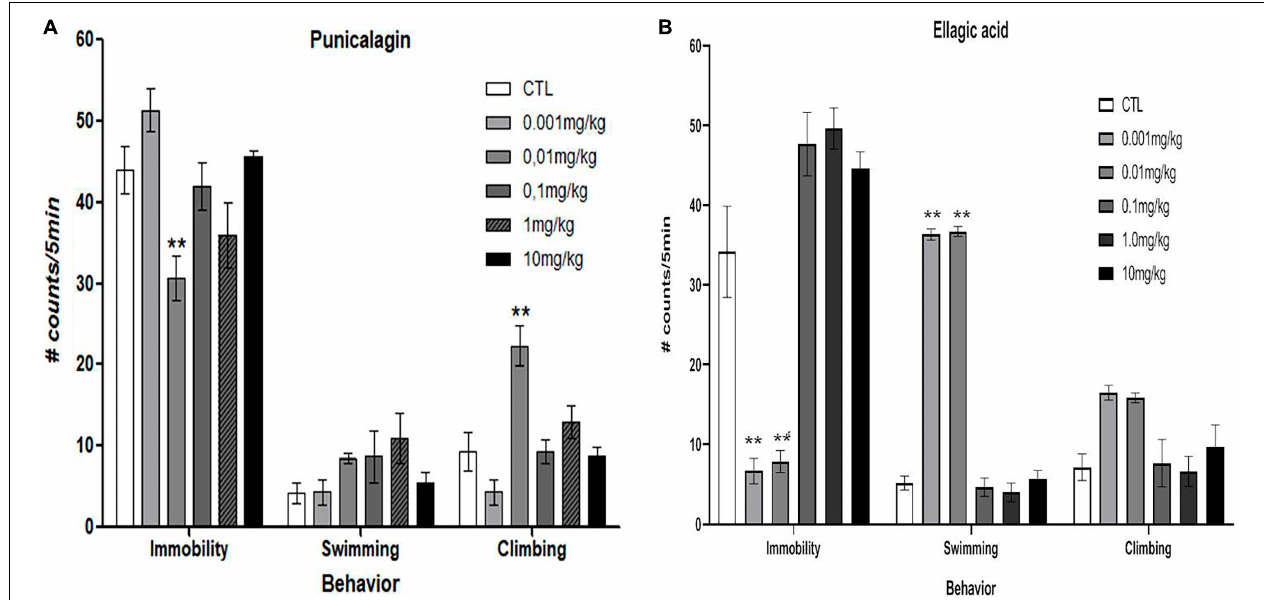
FIGURE 3 | Effect of chronic administration (0.001, 0.01, 0.1, 1.0, and 10 mg/kg, i.p, once a day/14 days) of commercial punicalagin [panel (A) , n = 7 per dose] and commercial ellagic acid [panel (B) , n = 7] in ovariectomized rats subjected to forced swimming test. Data are presented as the mean (S.E.M.) of the number of counts of immobility, swimming, and climbing behavior in a 5-min test session. Comparisons vs. control group (saline solution). One-way ANOVA test ** p < 0.001 versus control group.